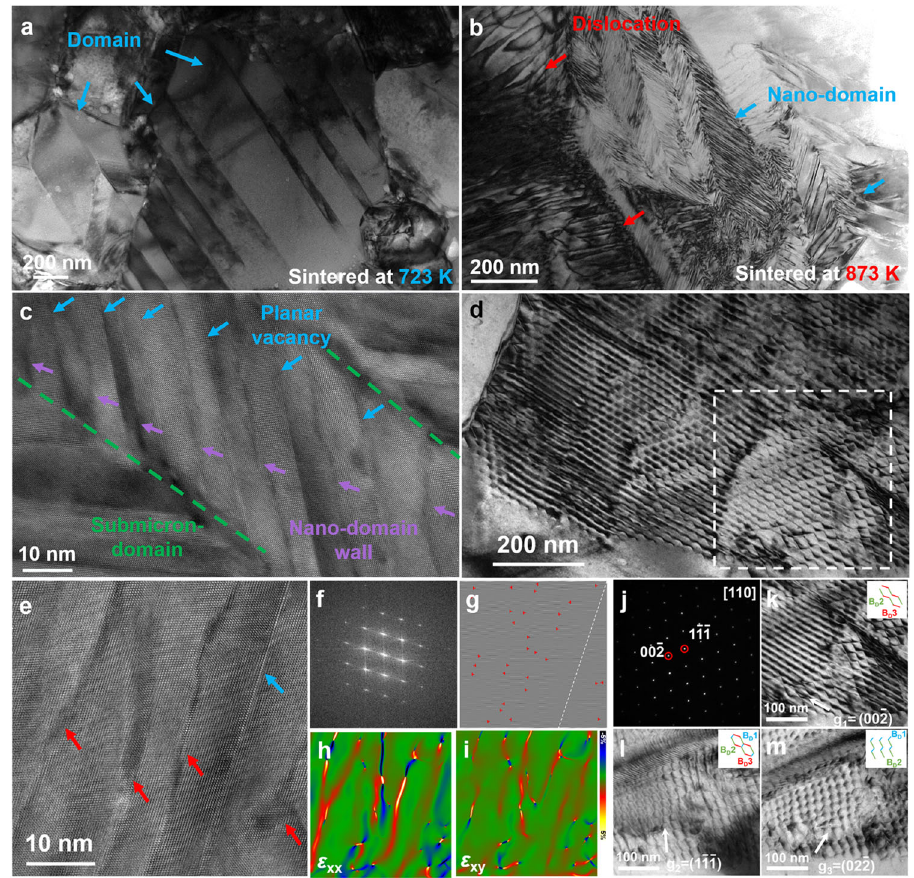
Fig. 2 | Microstructure evolution led by vacancies. a , b Low-magni fi cation TEM images of the Ge-de fi cient samples sintered at723K and 873K, respectively. c The HRTEM image of a randomly selected region in b showing the domain walls and planarvacanciesinthesamplesinteredat873K. d Low-magni fi cationTEMimageof the dislocation network in the sample sintered at 873K. e HRTEM image of